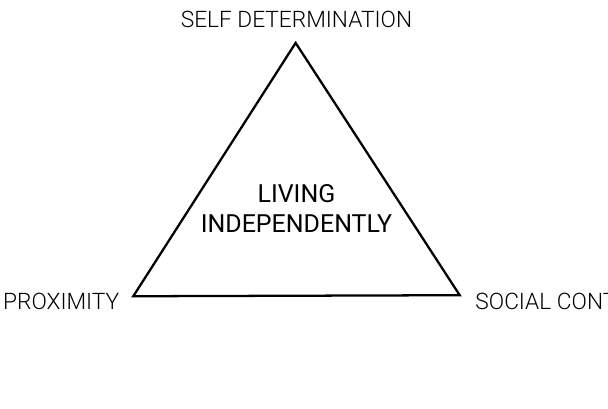
SELF DETERMINATION